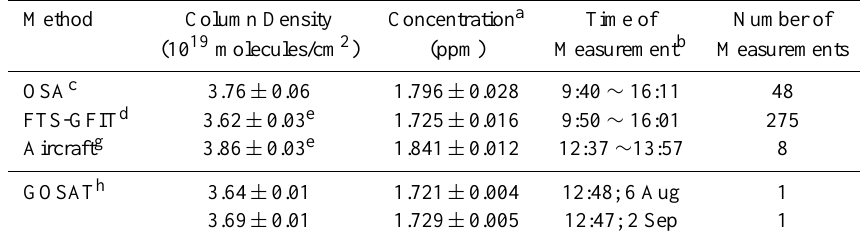
Table 2. Column densities and column average concentrations of CH 4 at the Moshiri observatory. Method